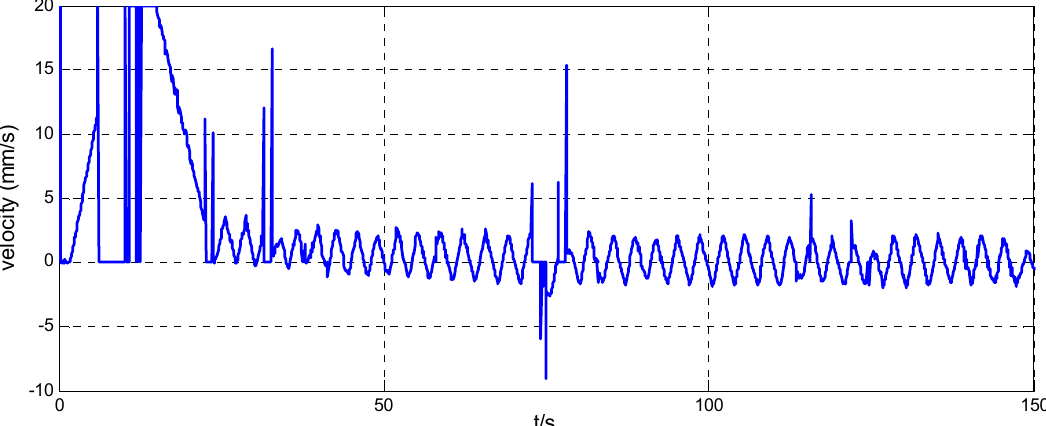
Figure 19. Velocity along the x-axis of the simulator when x ( 0 ) =